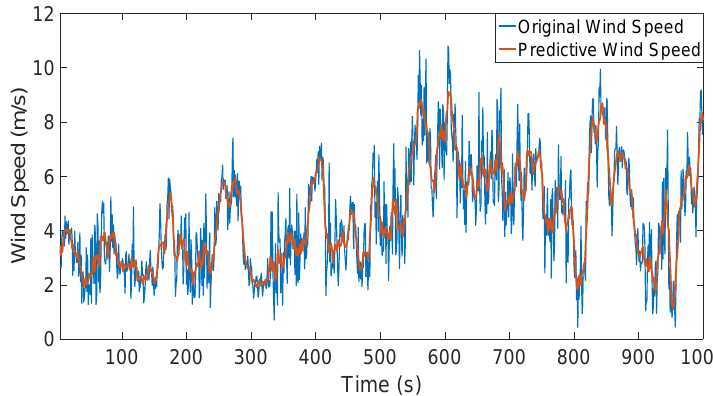
Figure 3. Comparison between the actual wind speed and predicted wind